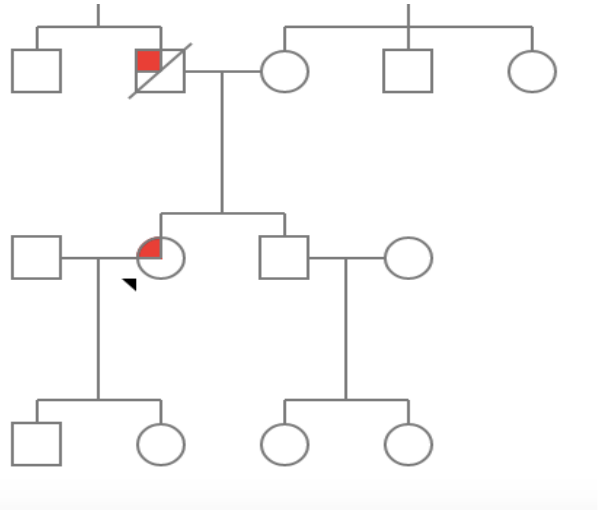
Figure 1: Family pedigree . Patient 1 is in generation 1 and had carci-­‐ noma ex pleomorphic adenoma after approx. 15 years without removal of primary tumor. Patient 2 is in generation 2 and had a pleomorphic adenoma. Offspring in generation 3 are still in their 20’s and younger than the average age range for